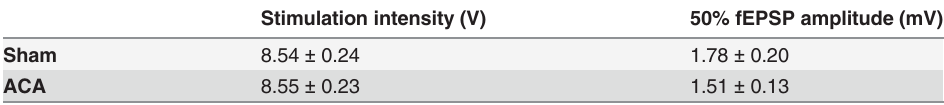
Table 2. Average stimulation intensity (V) required to induce 50% fEPSP amplitude